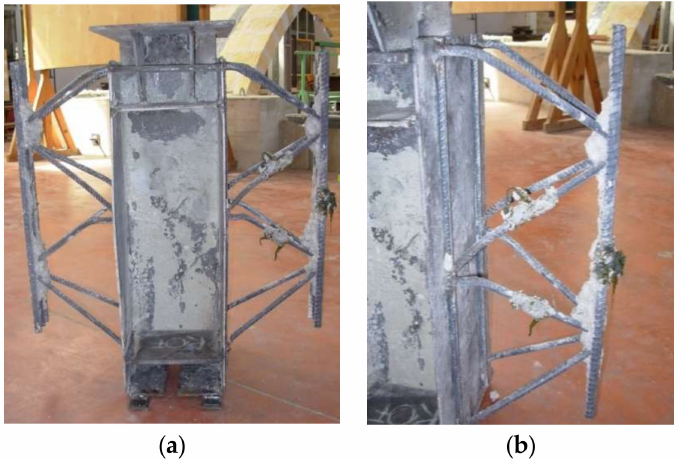
Figure 12. Deformed steel truss of specimen P1 at the end of the test (Badalamenti) [14]: ( a ) overall view; ( b ) zoom of deformed